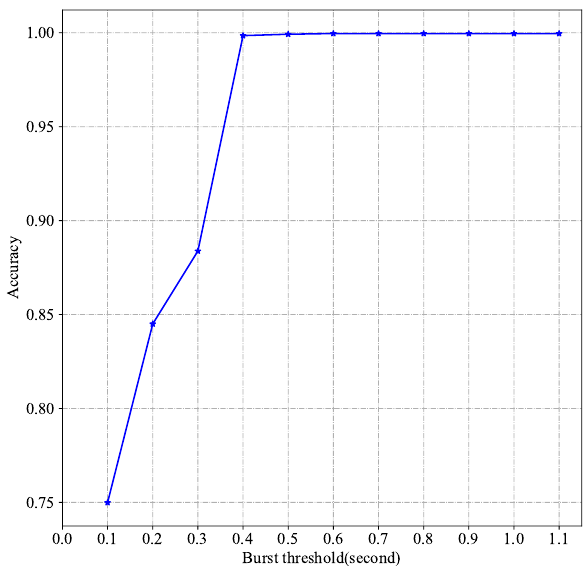
Figure 7. Effectiveness of detection accuracy with different burst